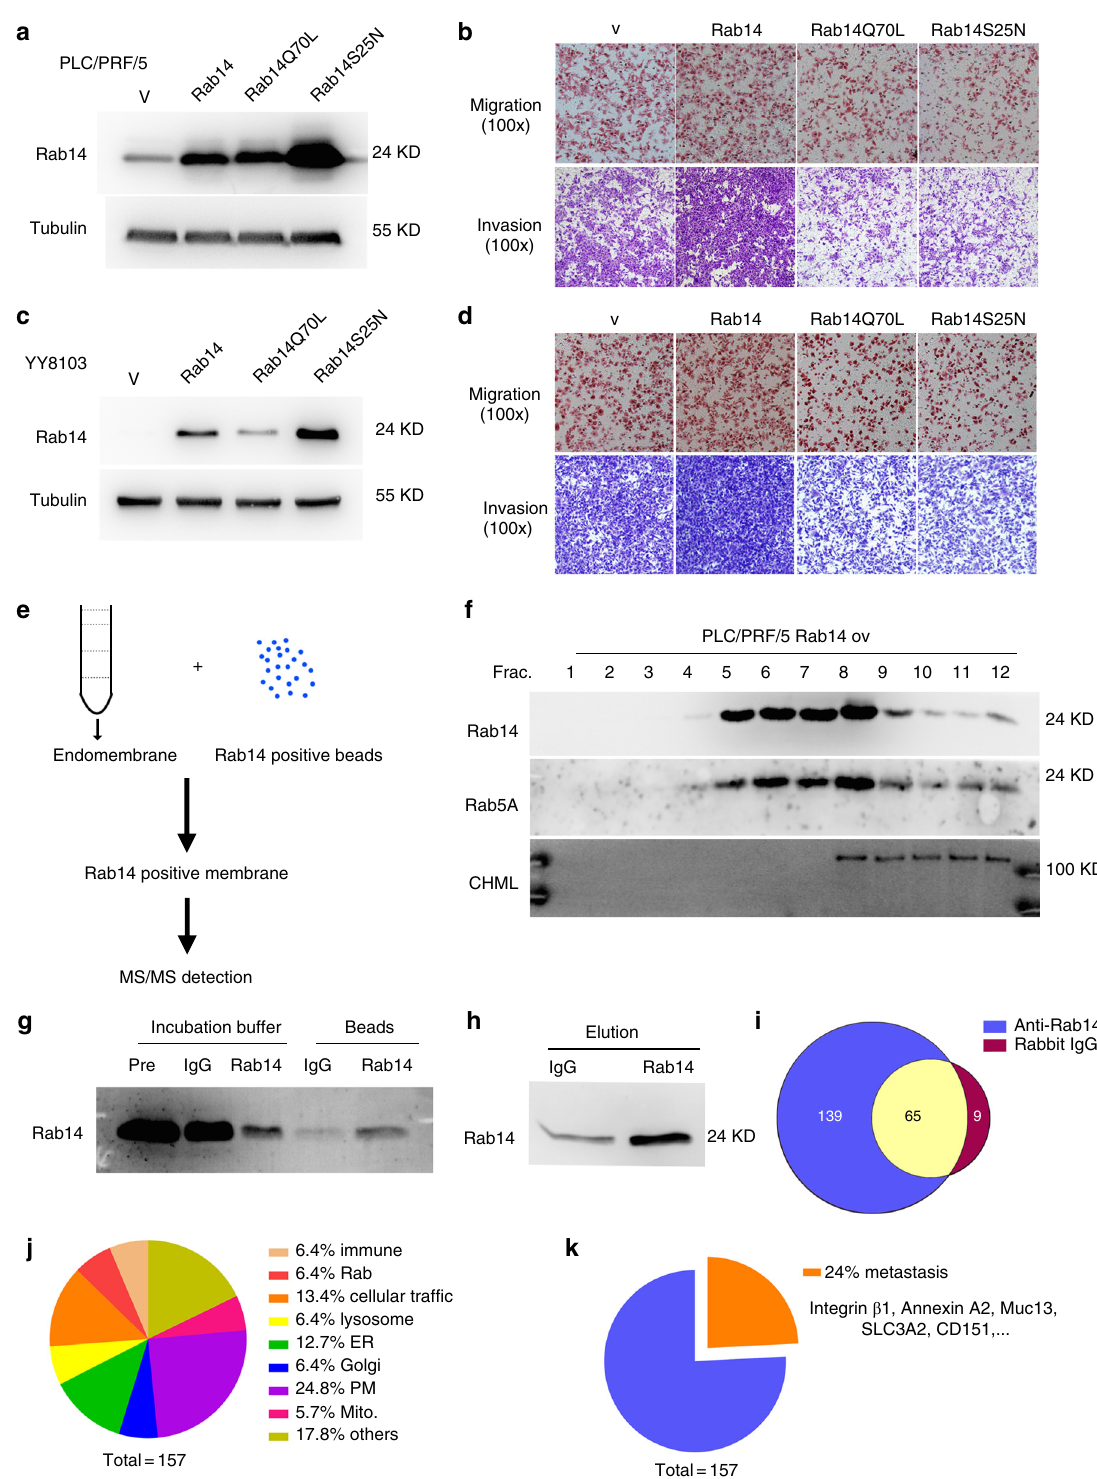
Fig. 7 Rab14-positive membrane fraction contains metastasis-promotional factors. a , c Western blot analysis of the overexpression ef fi ciency of Rab14WT and its mutants in HCC cell line PLC/PRF/5 and YY8103. V vector control. b , d Metastasis and invasion assays were conducted to detect these